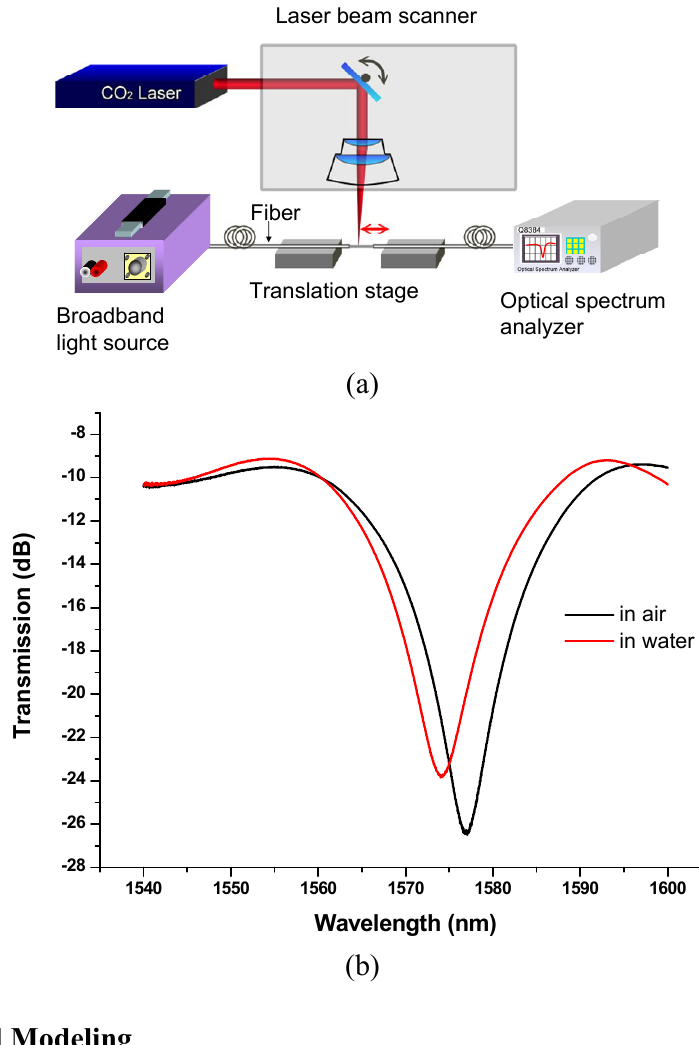
Figure 1. (a) Schematic for experimental setup of LPFGs fabrication; (b) transmission spectrum of an LPFG sensor in air and immersed in water at 25